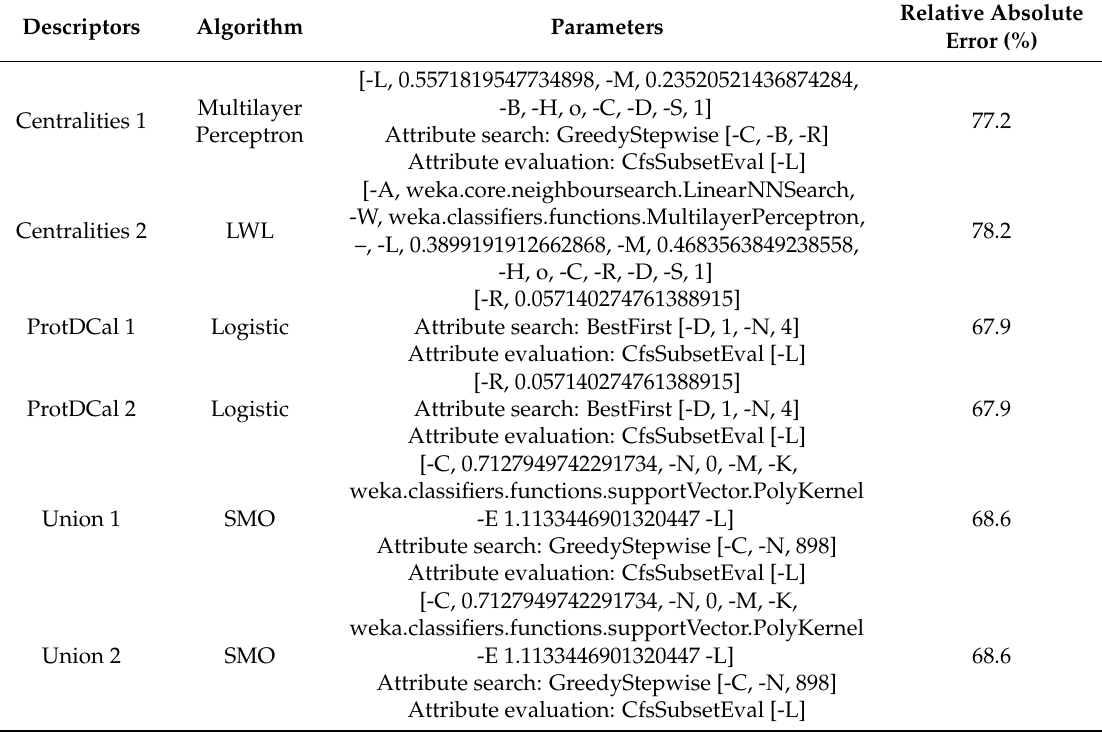
Table 1. Algorithms and parameters optimized for